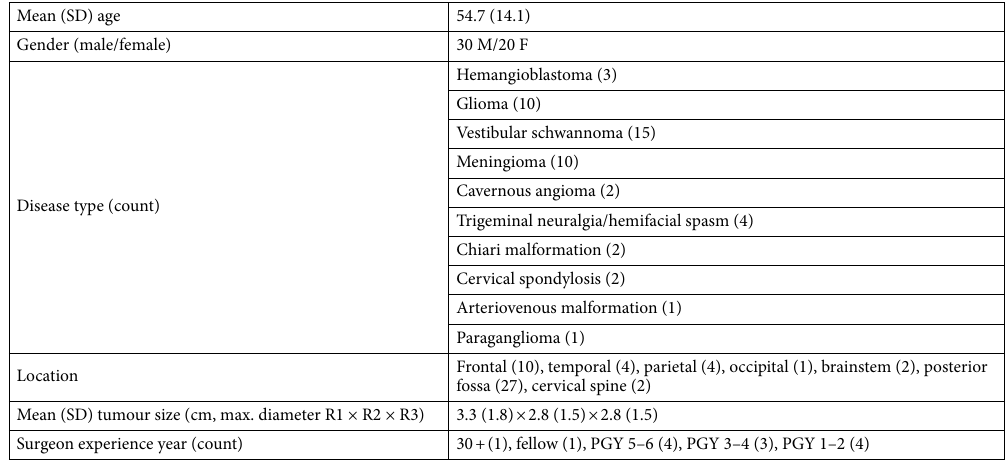
Table 2. Patient demographics, pathology, location, tumour size and surgeon experience